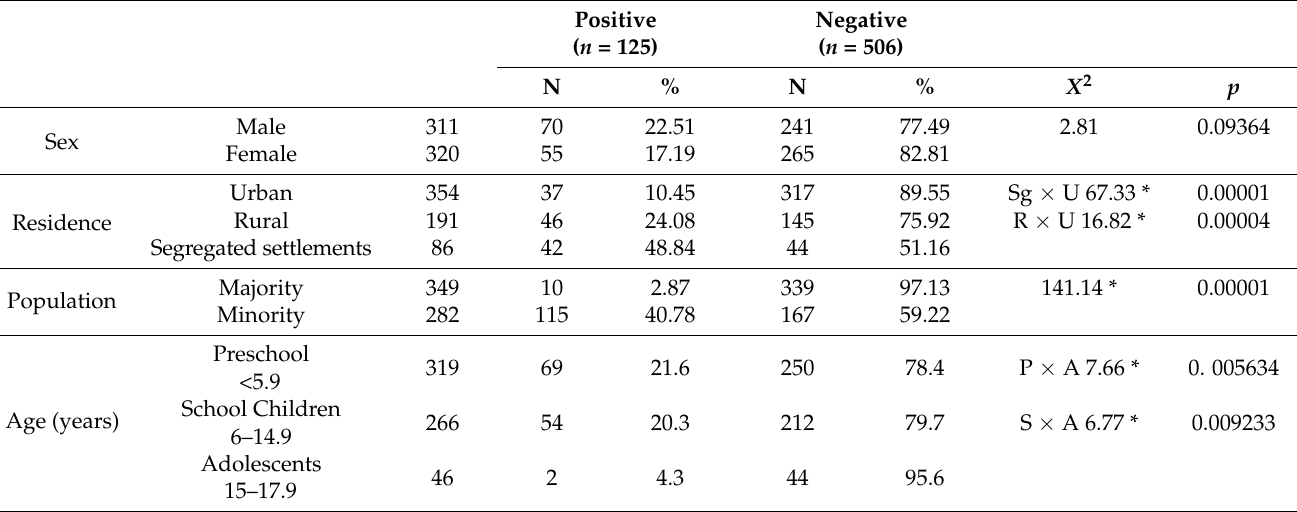
Table 3. Distribution of risk factors for positive stool parasitological